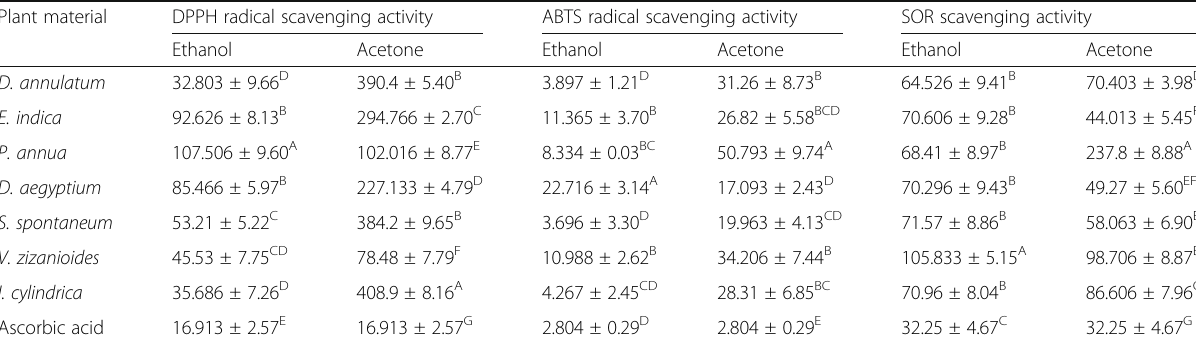
Table 2 Evaluation of IC50 values of free radical scavenging activities Plant material DPPH radical scavenging activity ABTS radical scavenging activity SOR scavenging activity Ethanol Acetone Ethanol Acetone Ethanol